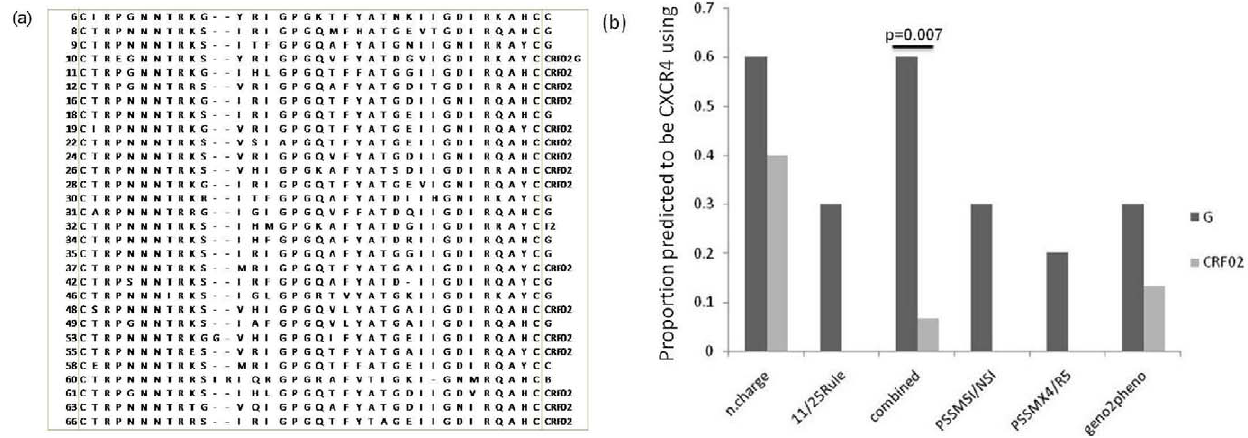
Figure 3. Env V3 amino acid sequences and CXCR4 usage potential of isolates. (a) Env V3 amino acid sequences; each sequence is flanked by its sample number on the left and the subtype on the right. (b) A chart of relative CXCR4 usage prediction based on net charge rule [n.charge], the 11/25 rule, the combined criteria from the 11/25 and net charge rules [combined] as described by Raymond et al (2009), the web-based specific position-specific scoring matrixes (PSSM) programme and the web-based Geno2pheno